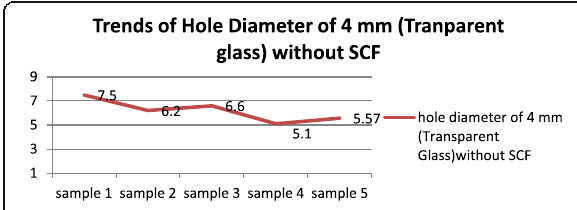
Fig. 13 Graphical Representation of Hole diameter of 4 mm Transparent Glass Pane without SCF